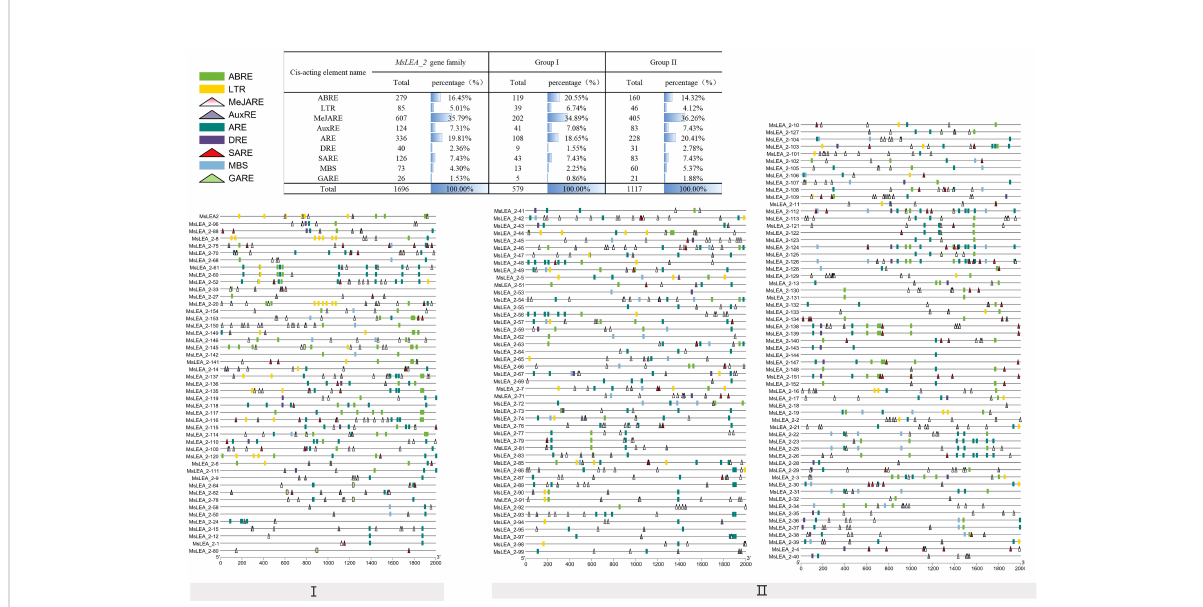
FIGURE 8 Predicted cis -element analysis of the MsLEA_2 gene family. Different colors and shapes represent different cis -elements. Number of each cis - element of the MsLEA_2 gene promoter region (2.0 kb upstream of the translation start site) was shown in the table on the top of the fi gure. Abbreviations were used to indicate different cis -elements: “ ABRE ” refer to Abscisic Acid Responsive Element; “ MeJARE ” refer to Methyl Jasmonate Responsive Element; “ DRE ” refer to Drought Response Element; “ MYB ” refer to MYB Transcription Factors; “ MYC ” refer to MYC Transcription